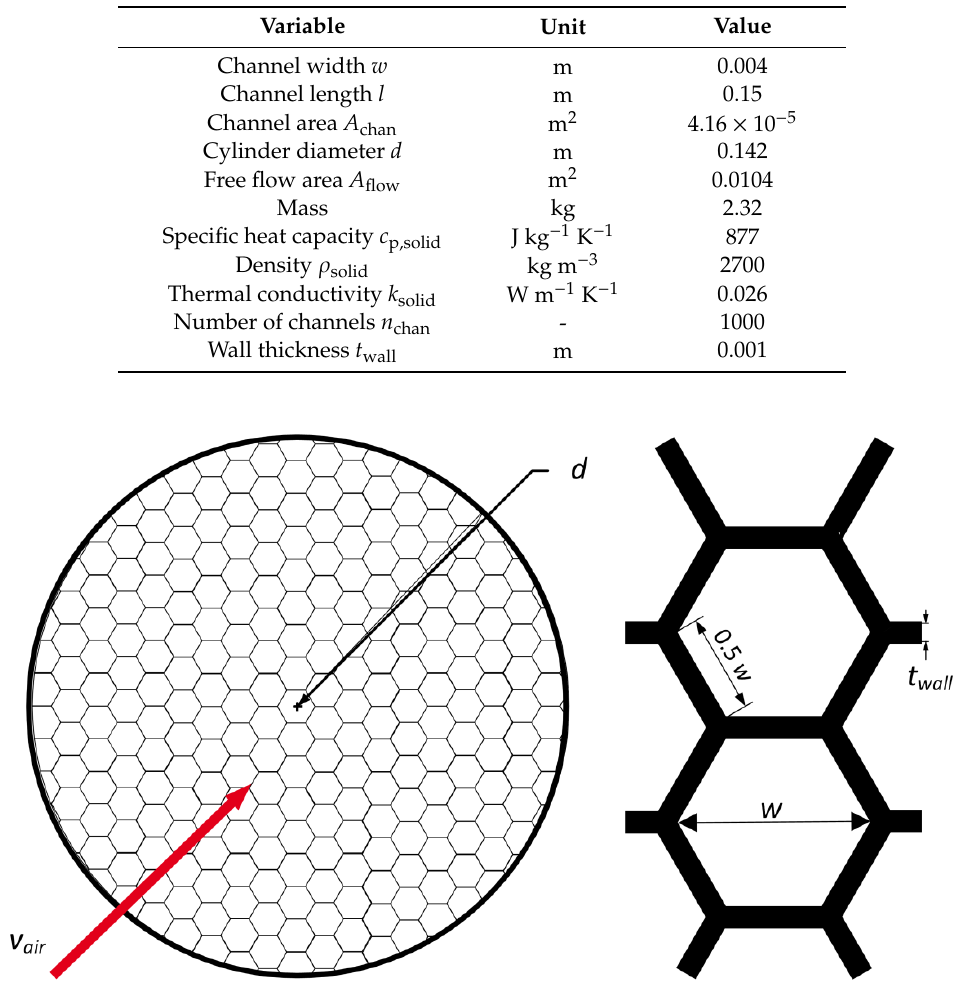
Table 1. Honeycomb heat exchanger properties with hexagonal shape.